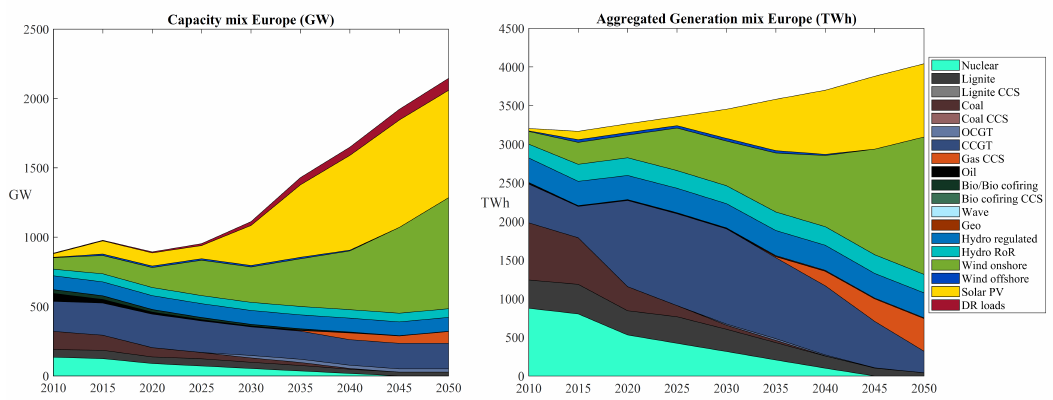
Figure 5. Europe’s DR and Generation Capacity (GW) and Energy Generation